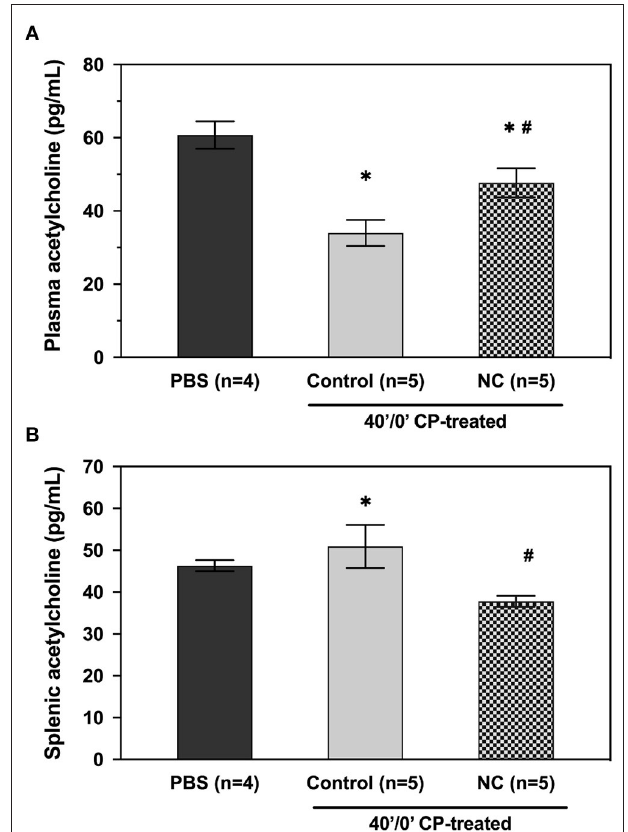
FIGURE 7 | NC attenuates the effect of post-ischemia cardiac perfusate on plasma (A) and splenic (B) acetylcholine levels. Cardiac perfusate was isolated following 40min of ischemia and administered to naive mice at a dose of 2 µ l/g i.v. bolus. Plasma and splenic acetylcholine levels were then evaluated in treated groups that remained normothermic or underwent NC. PBS, phosphate-buffered saline; NC, topical neck cooling; CP, cardiac perfusate;’ min; * p < 0.05 vs. PBS-treated group; # p < 0.05 vs. CP-treated control group.